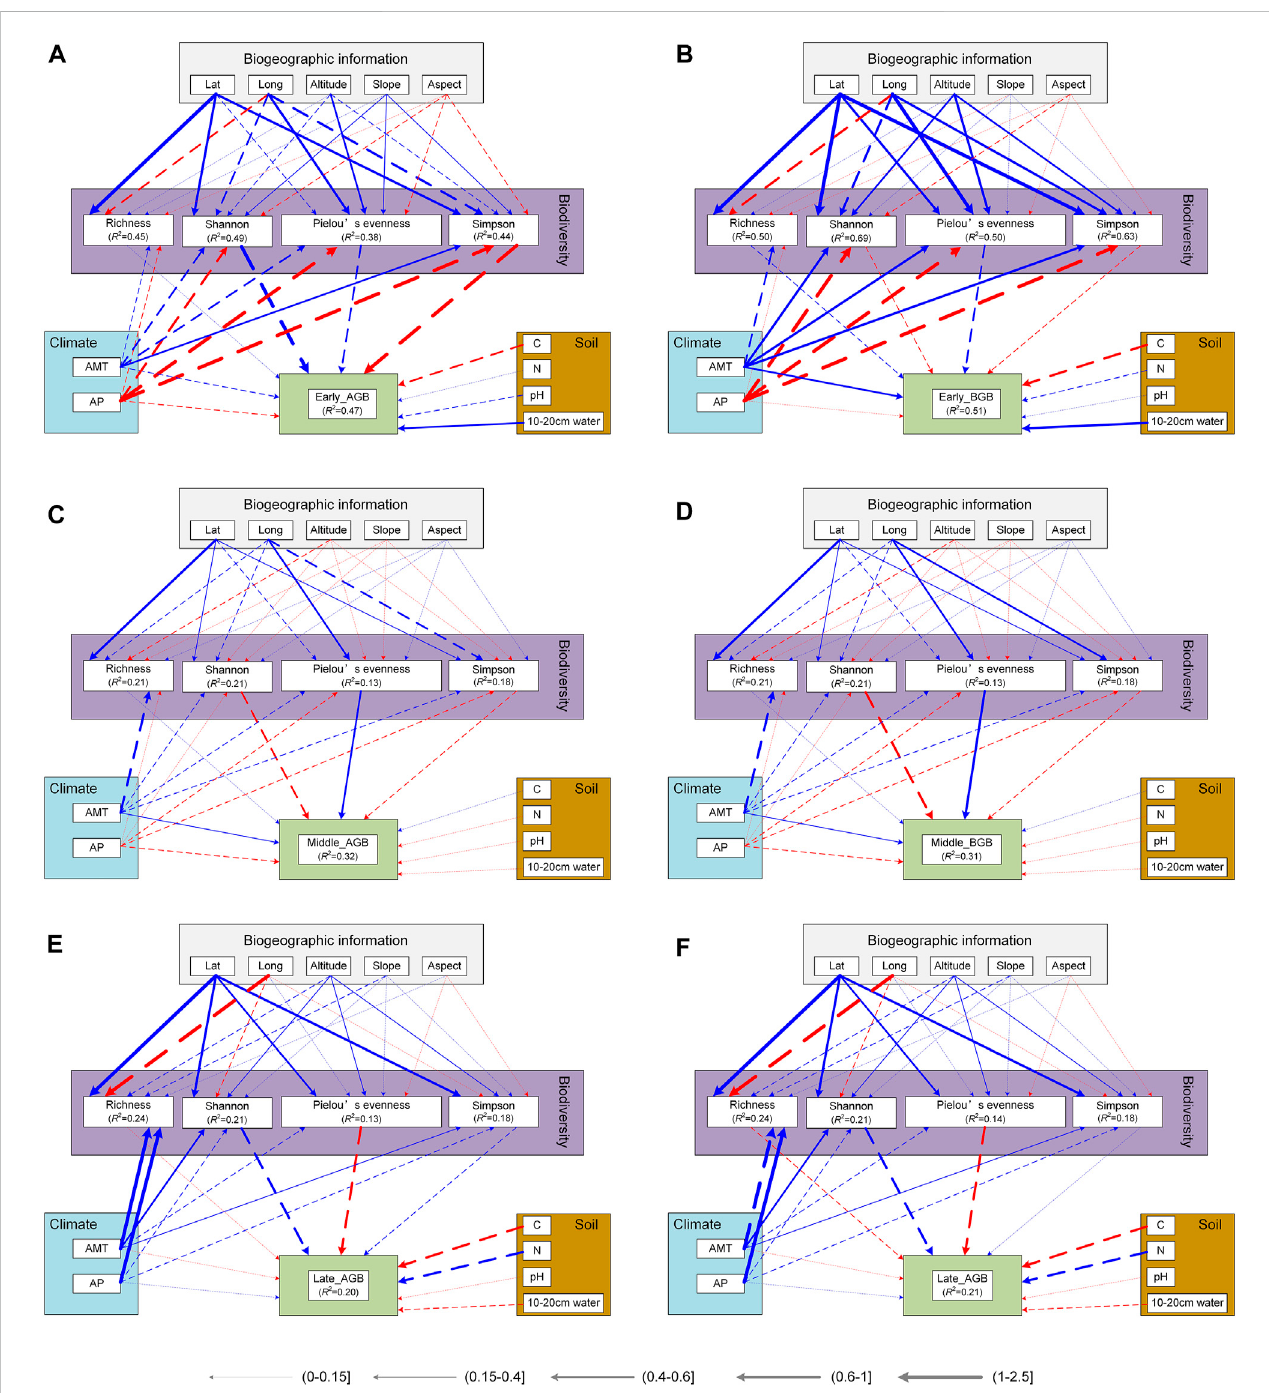
FIGURE 7 StructuralEquationModelingofdrivingfactorsofbiomassindifferentrestorationstages.Thesolidanddashedlinesrepresentsigni fi cantandinsigni fi cant relationships, respectively. Red and blue represent positive and negative effects, respectively. Line width is related to correlation. C, total carbon; N, total nitrogen; AP, annual precipitation; AMT, annual mean temperature; Lat, latitude; Long,